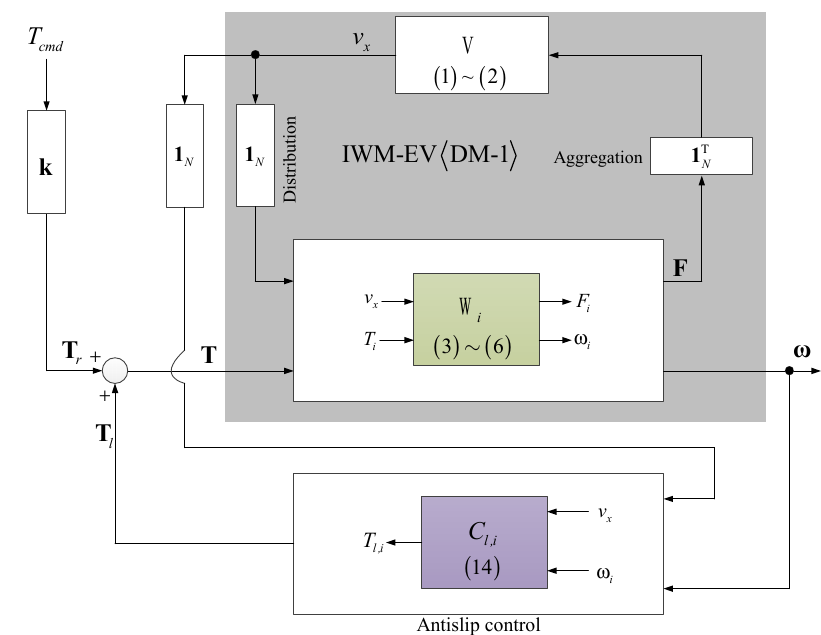
Figure 7. Expression of anti-slip control system of IWM-EV using DM-1.